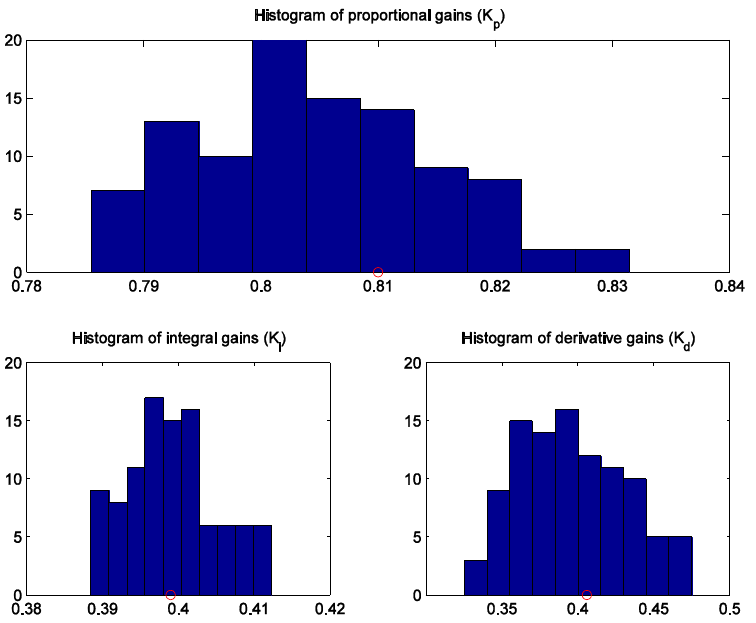
Figure 11. Histograms of the calculated controller parameters for 100 runs in noisy open-loop responses obtained using the FWLS method. The values of the controller parameters obtained with undisturbed open-loop responses without noise are represented by red